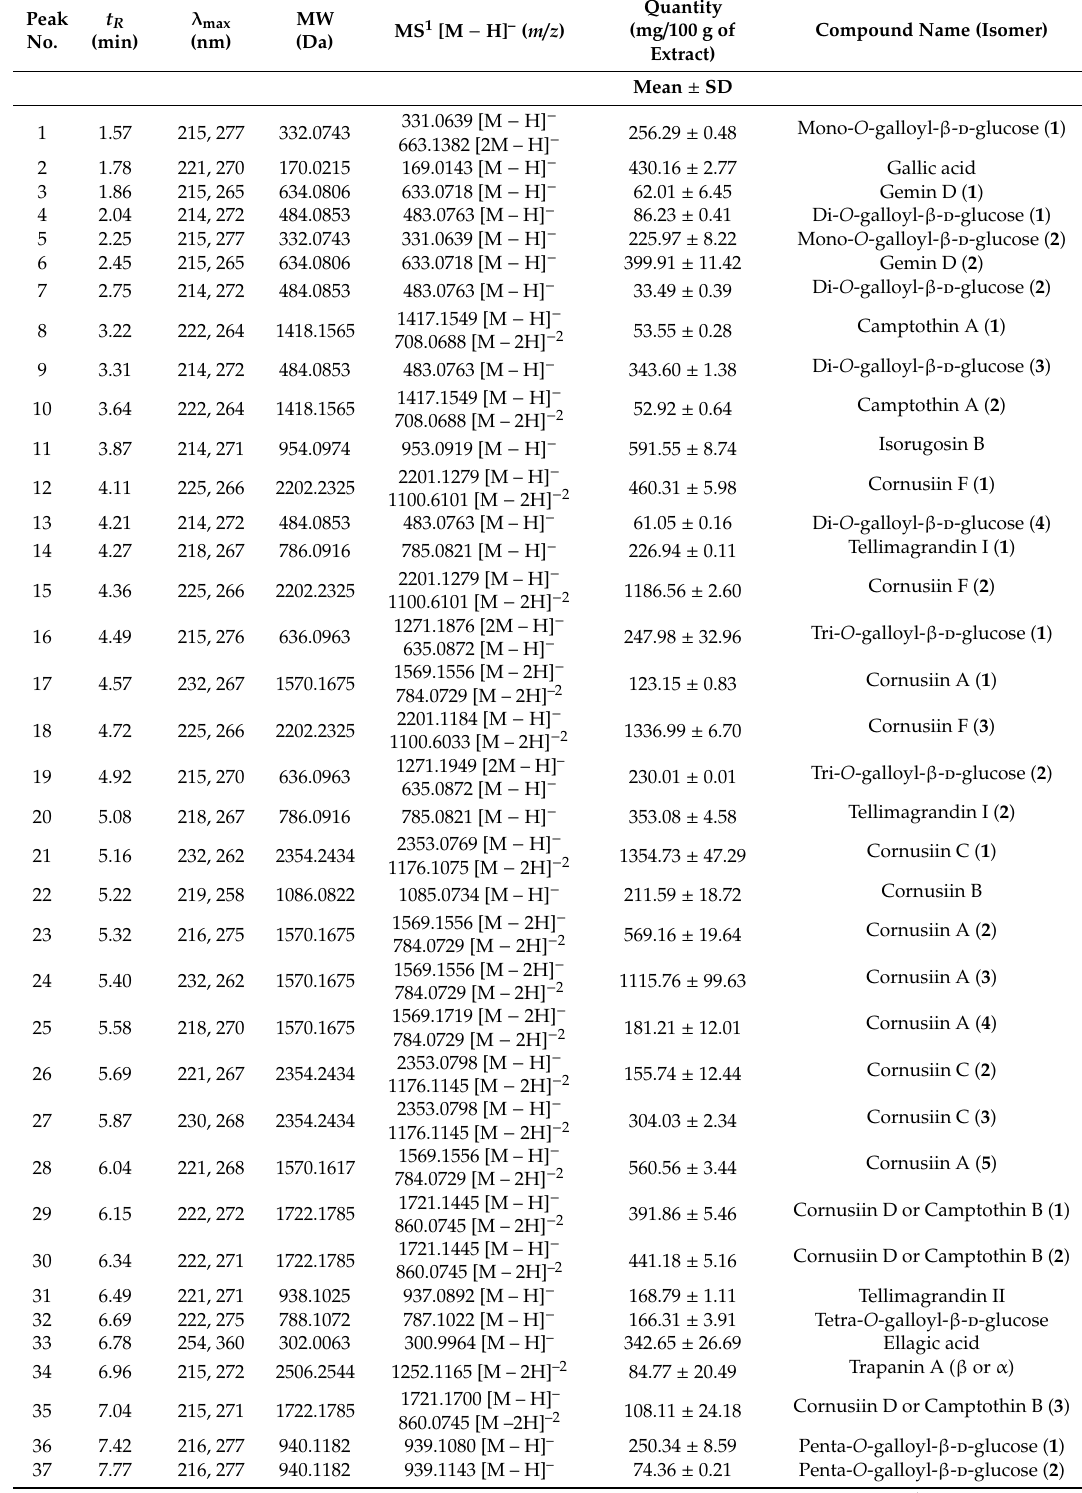
Table 1. UPLC-ESI-qTOF-MS / MS and HPLC-DAD identification of hydrolyzable tannins in the extract of cornelian cherry